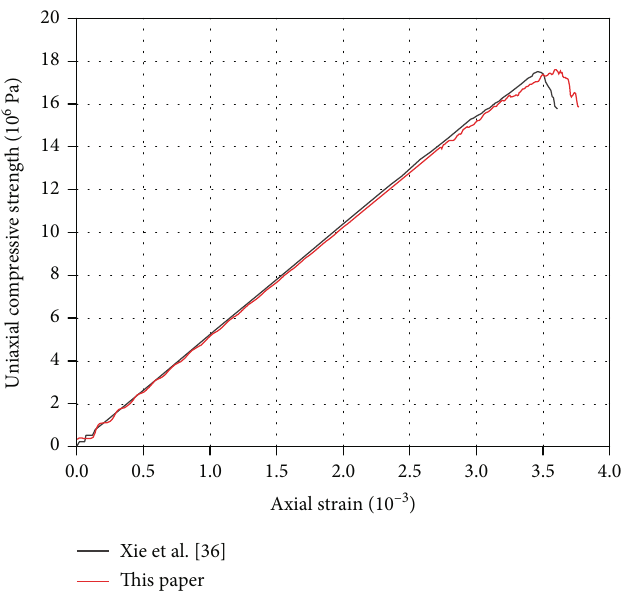
Figure 9: Comparison of uniaxial compression test results of limestone.